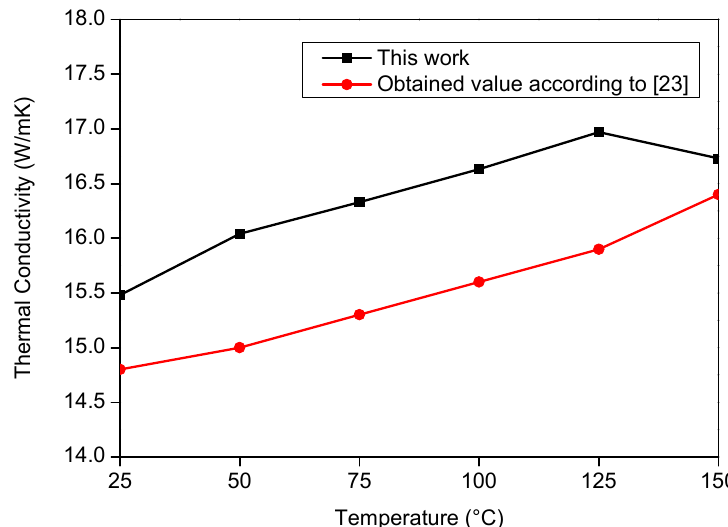
Figure 15. Comparison between the literature values with the estimated results of ρ c p on the AISI 304 stainless steel sample.